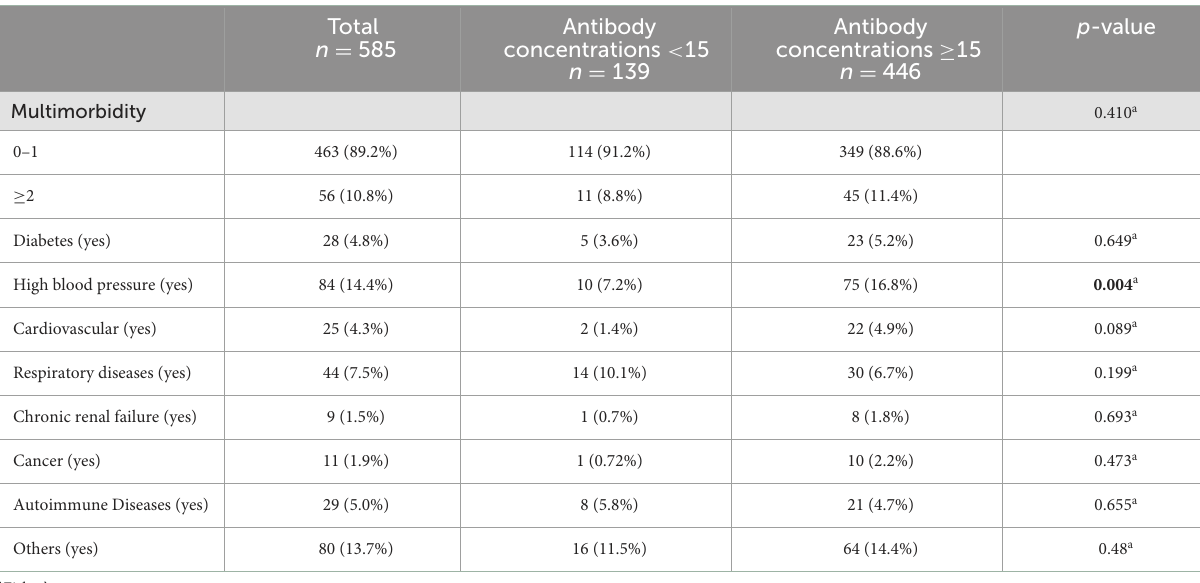
TABLE 2 Chronic self-reported diseases of the 584 participants at baseline, by antibody